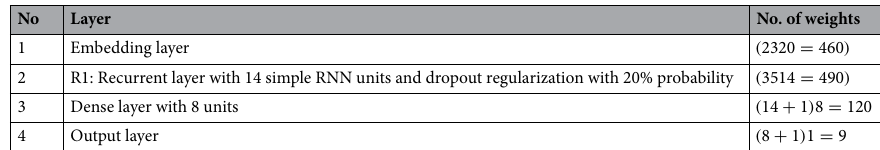
Table 4. RNN architecture using SimpleRNN neurons for CarboxE site identification.